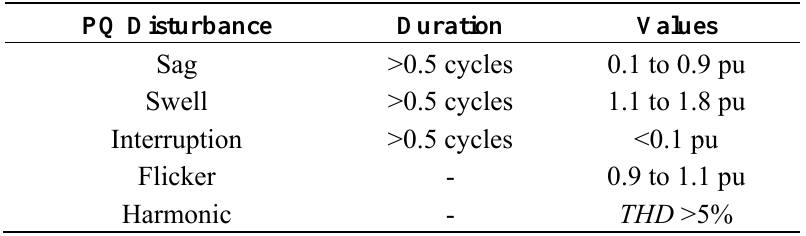
Table 1. Power quality disturbances